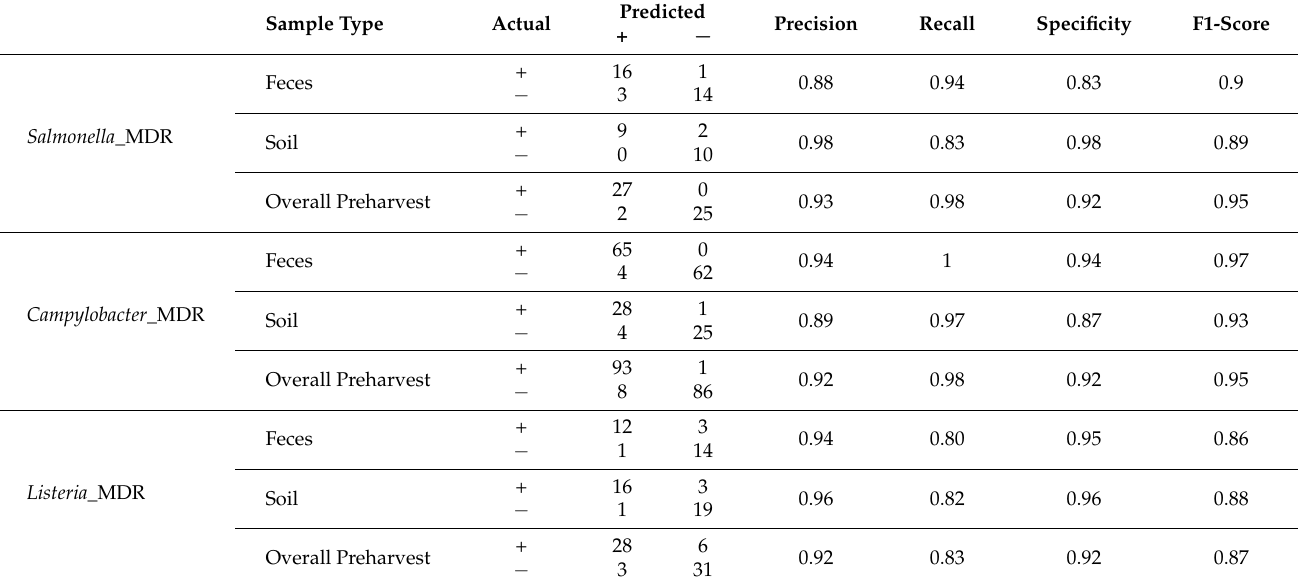
Table 2. The classification results of MDR predictive preharvest (feces and soil) models. Models are trained with farm practices and environmental physicochemical variables.